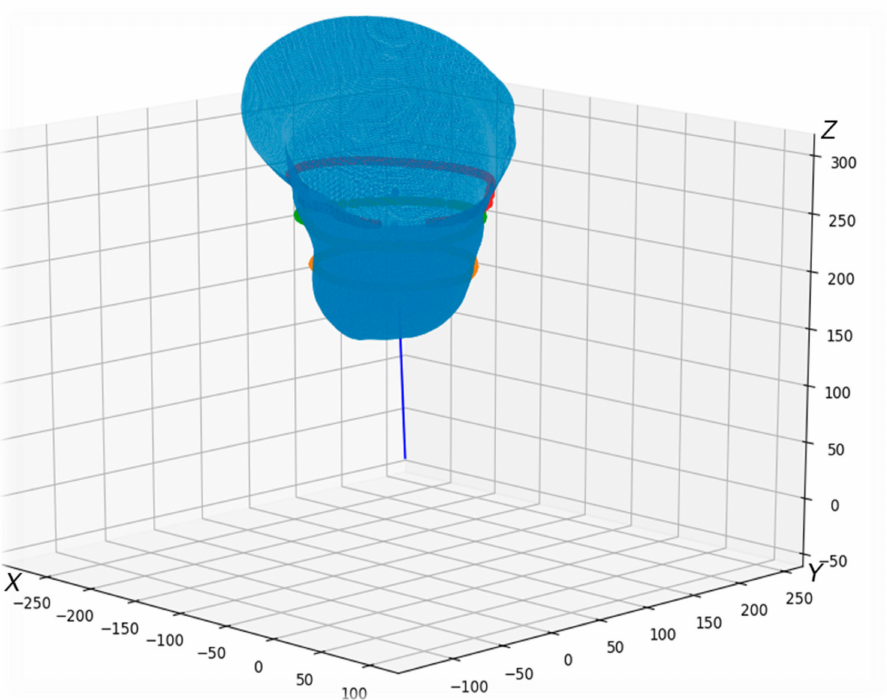
Figure 3. Three-dimensional (3D) model with cross-sections and fitting line that passed through its centers.